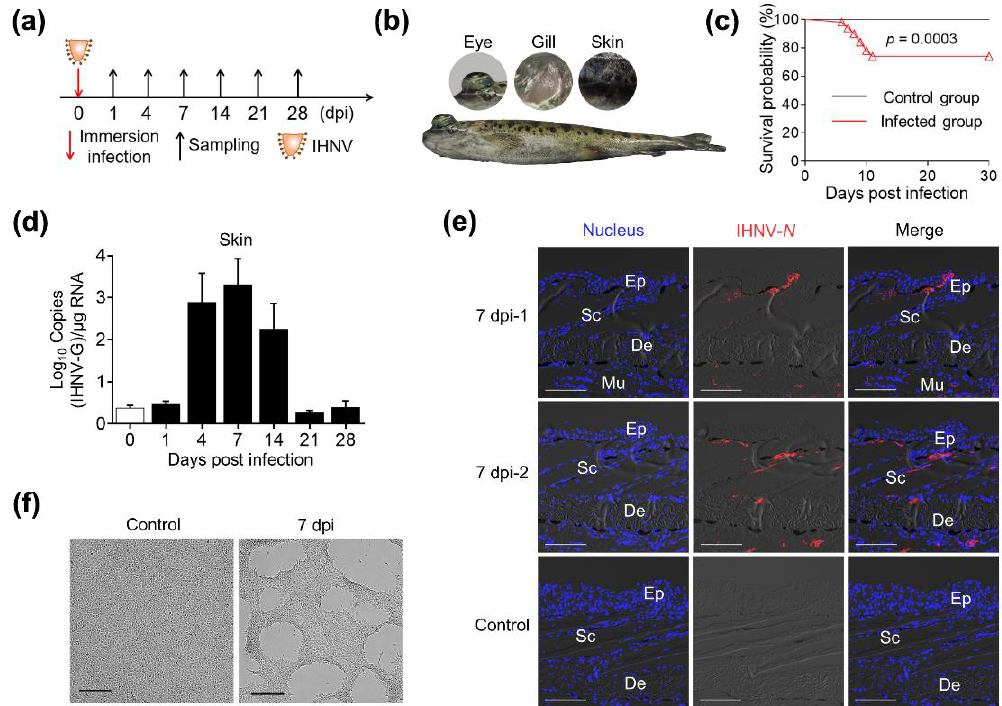
Figure 1. Successful invasion of IHNV into rainbow trout after immersion infection. ( a ) A schematic diagram about the timing of infection and sampling. ( b ) Fish mortalities and clinical symptoms were recorded daily for 30 days post IHNV infection. Symptoms of exophthalmia, pale gills, and darkening of the skin appeared in diseased fish 4 to 7 days post infection. ( c ) Cumulative survival rates of control and IHNV-infected group. Group comparisons for survival data were made by log-rank test statistics. ( d ) IHNV-G gene viral load (log10) at different time points was assessed in skin samples using a RT-qPCR assay. ( e ) Immunofluorescence staining of IHNV in skin paraffin sections from control and infected fish (7 dpi) (n = 6). IHNV-positive cells (red) were stained with an anti-IHNV-N mAb; nuclei were stained with DAPI (blue). Ep, epidermis; Sc, scale; De, dermis. Scale bars, 100 μm. ( f ) Cytopathic effects on EPC cells after incubation with skin homogenate supernatant from control fish and 7 dpi fish. Scale bars, 100 μm.